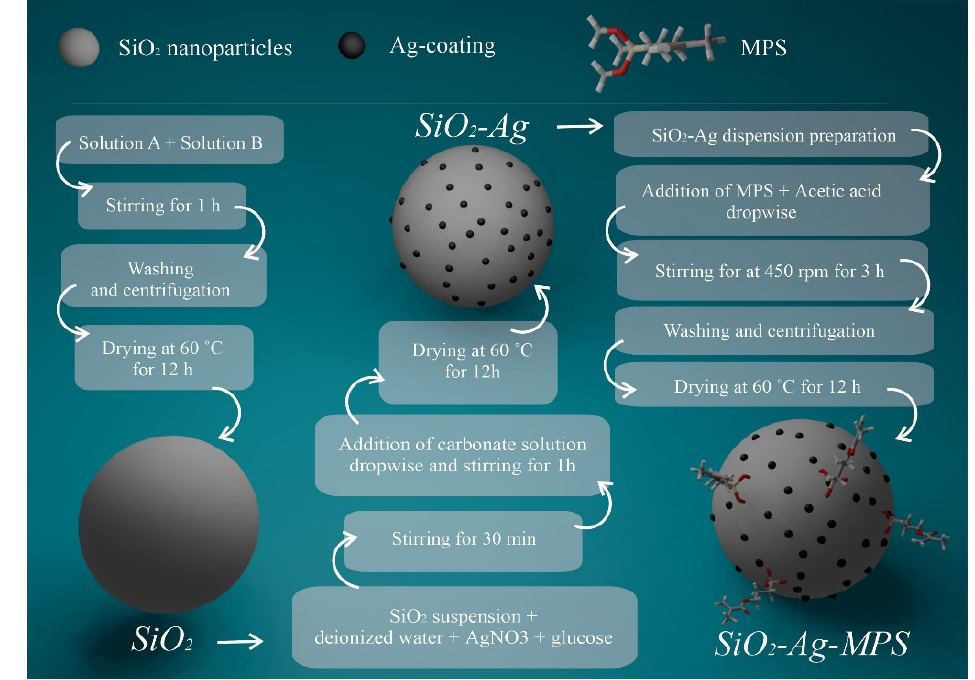
Figure 1. Schematic diagram of the synthesis of SiO 2 , SiO 2 -Ag and SiO 2 -Ag-MPS.